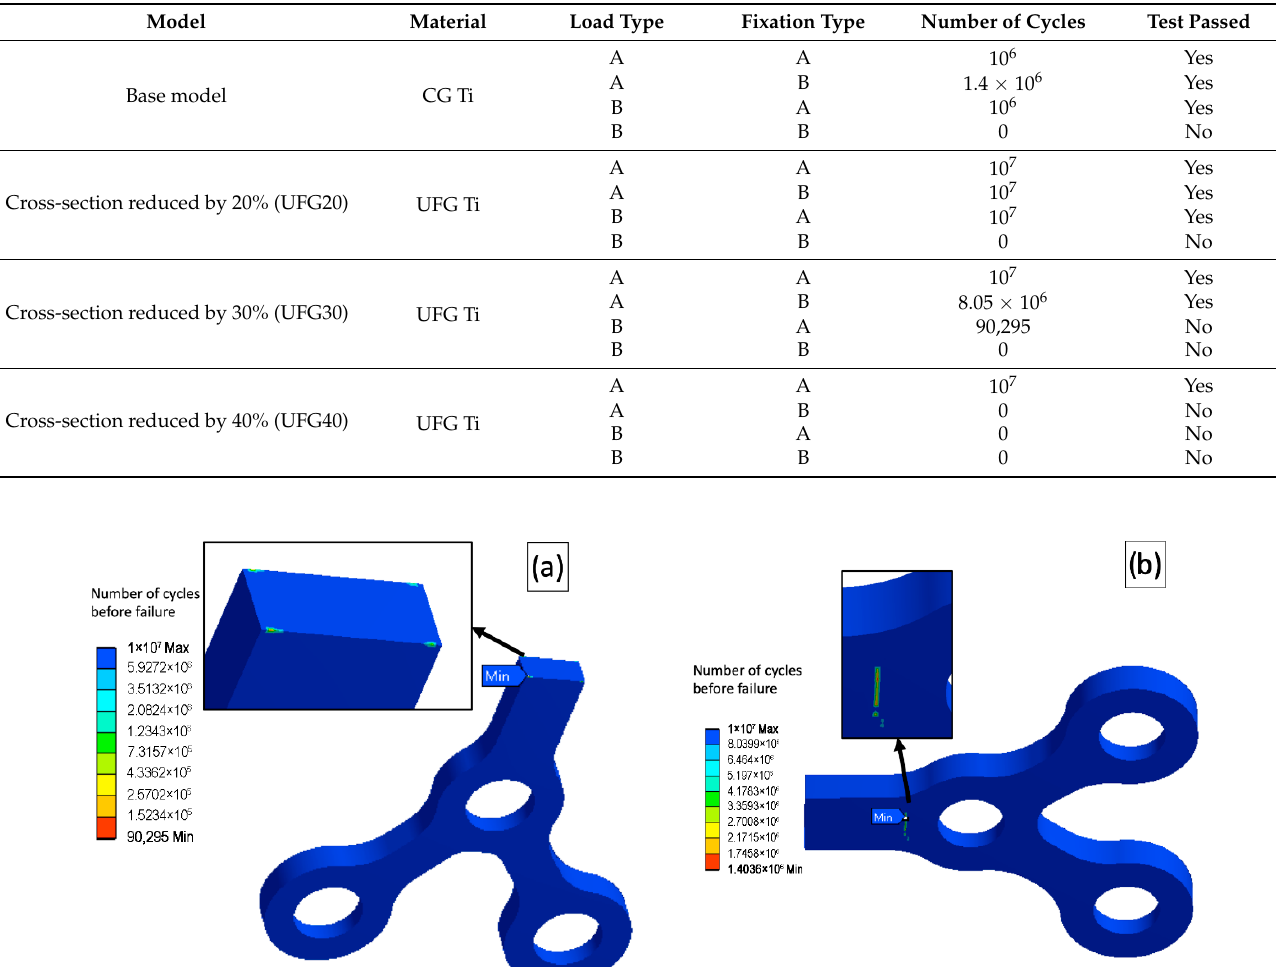
Table 4. Results of the virtual fatigue tests for the maxillofacial surgery